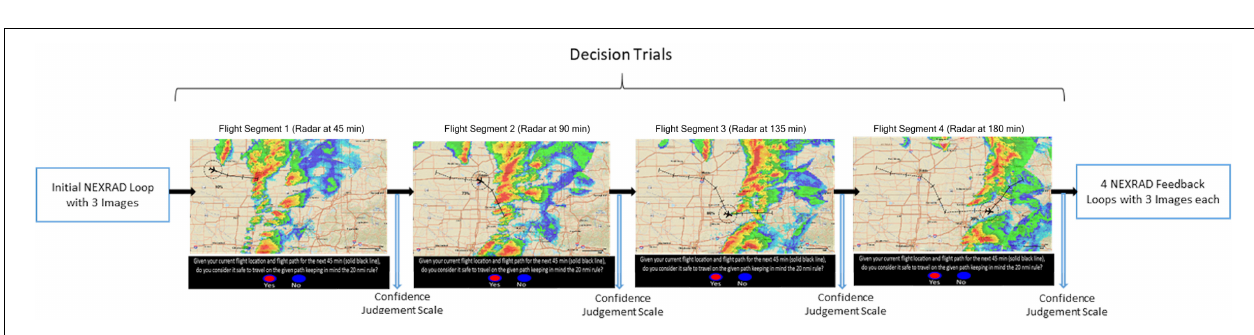
FIGURE 5 | Elicitation for unfolding trials in the test phase. The four NEXRAD images depict four 45-min segments for a 3-h flight.